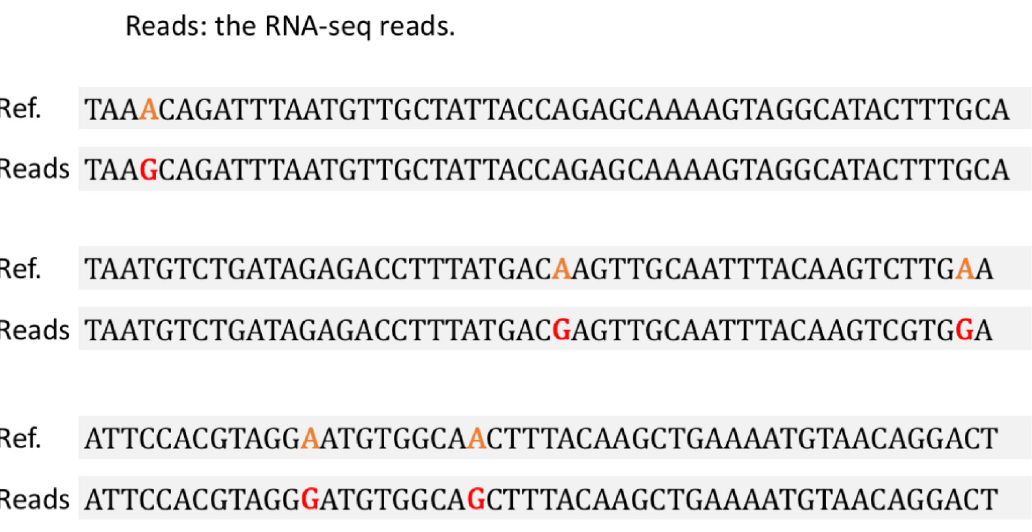
Fig 3. An example of an alignment between an RNA-seq read and the reference sequence of SARS-CoV-2. The five A-to-G mismatch sites are colored in the Fig.